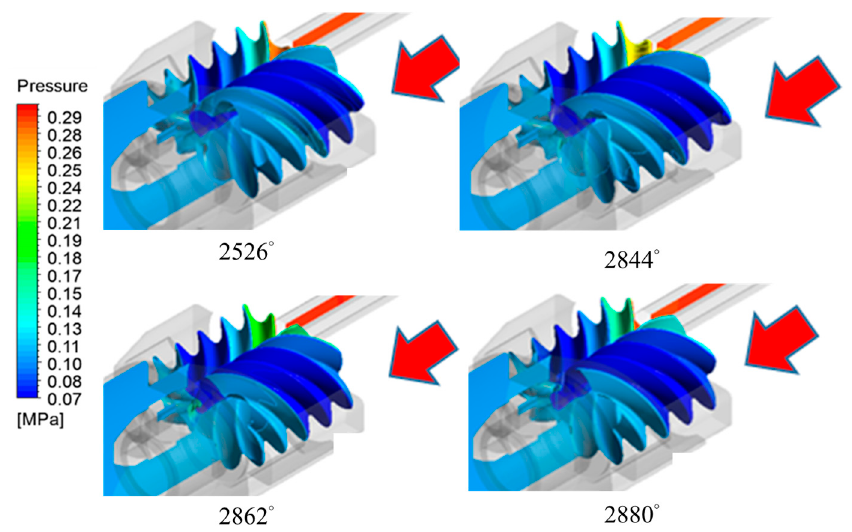
Figure 13. The pressure distribution at different angles (Red arrow: the inlet flow direction). The leakage fl ow is plo tt ed in Figure 14, and primary leakage spots are marked by red rectangles. These leakage spots were mainly observed at the front gap, rotor-tip hous- ing, and interlobe gaps. The high-velocity leakages, above 150 m·s − 1 , were found within the front and interlobe gaps. The leakage fl ow through the blow hole can also be observed, and this was mainly caused by the pressure di ff erence between the high- and low-pres- sure working chambers in the axial direction. The leakage fl ow through the blow hole was